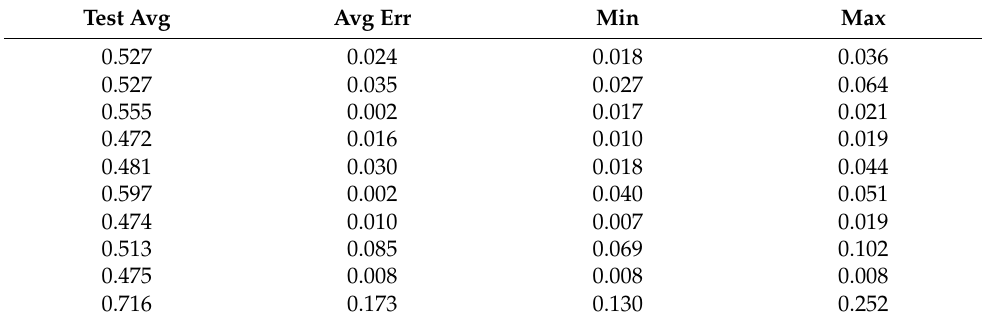
Table A37. Set 1, trials 21–30 data (actual PR value).